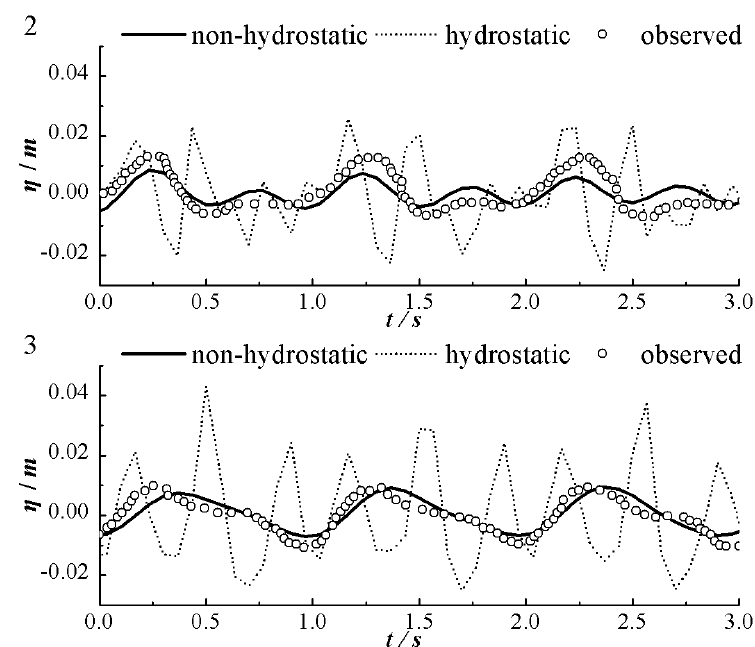
Figure 12. Simulated η by the non-hydrostatic (solid line) and hydrostatic model (dotted line); experimental data (circled) from Stations 1–3.